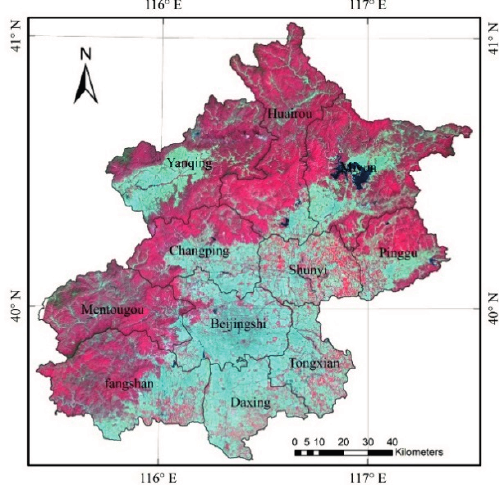
Figure 1. The location of the study area and the Landsat OLI data acquired on 12 May 2013 (presented in false color image: R = NIR, G = red, B =